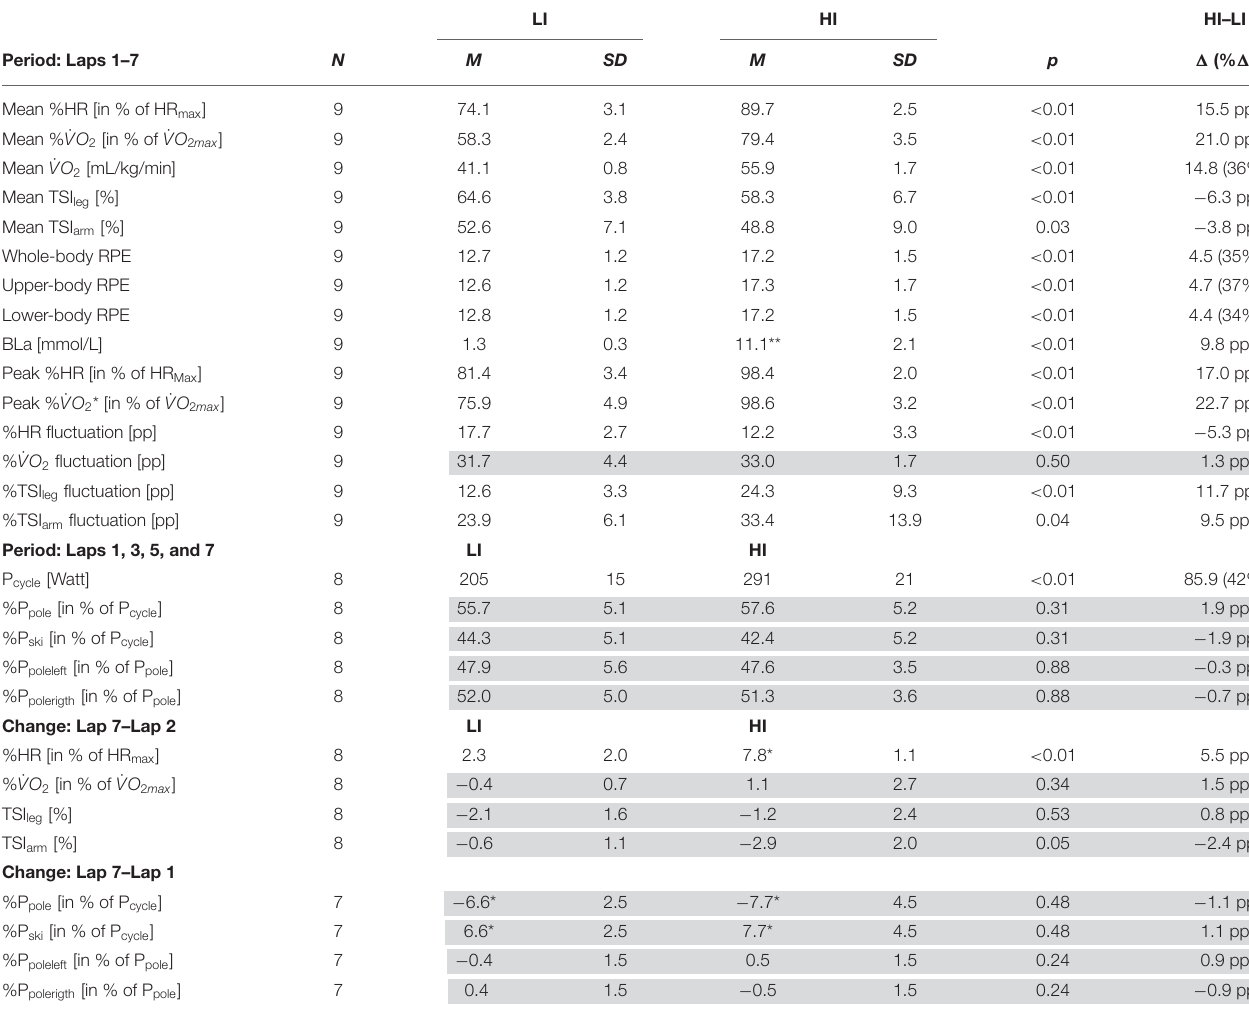
TABLE 2 | Heart rate (HR), oxygen uptake ( ˙ VO 2 ), tissue saturation index (TSI) for the leg (TSI leg ) and arm (TSI arm ), power variables, rate of perceived exertion (RPE), and blood lactate (BLa) for the low-intensity (LI) vs. high-intensity (HI) sessions, with means ( M ), standard deviations ( SD ), and p -values. LI